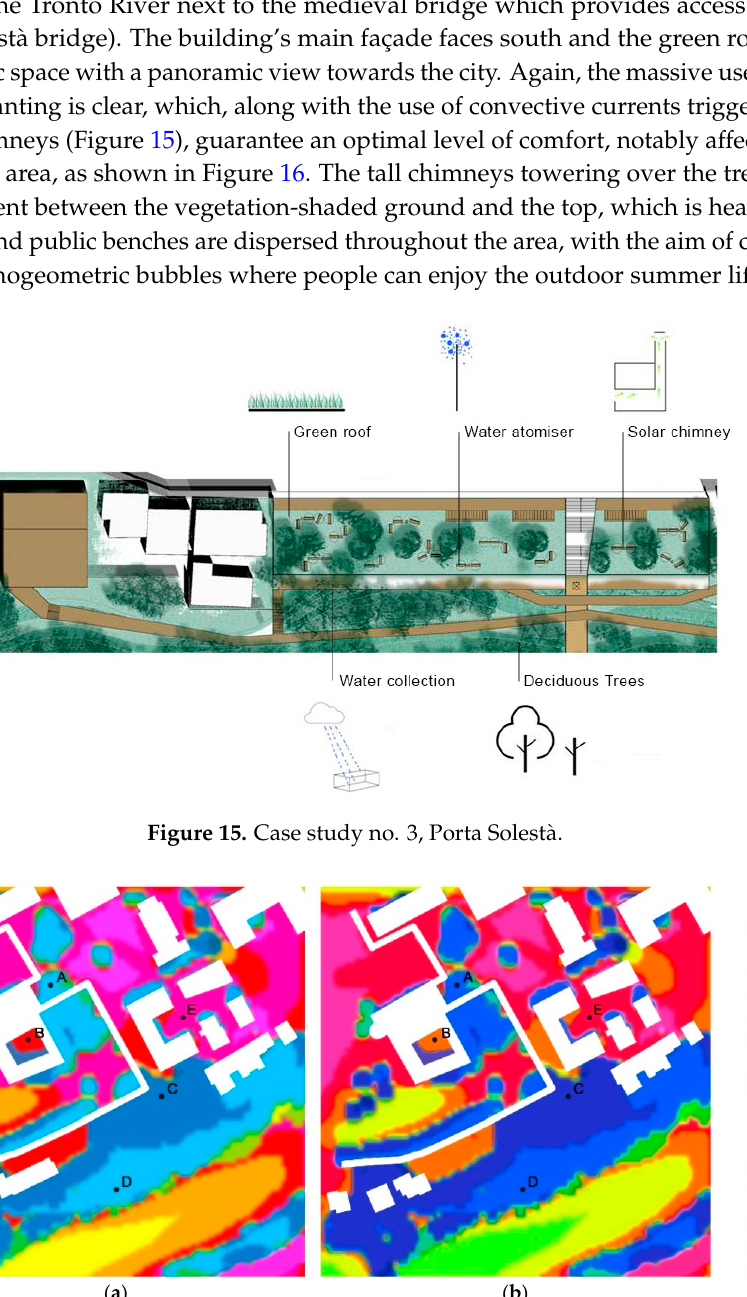
Table 1. Ex S.I.M.E.—Temperature (°C) before and after.